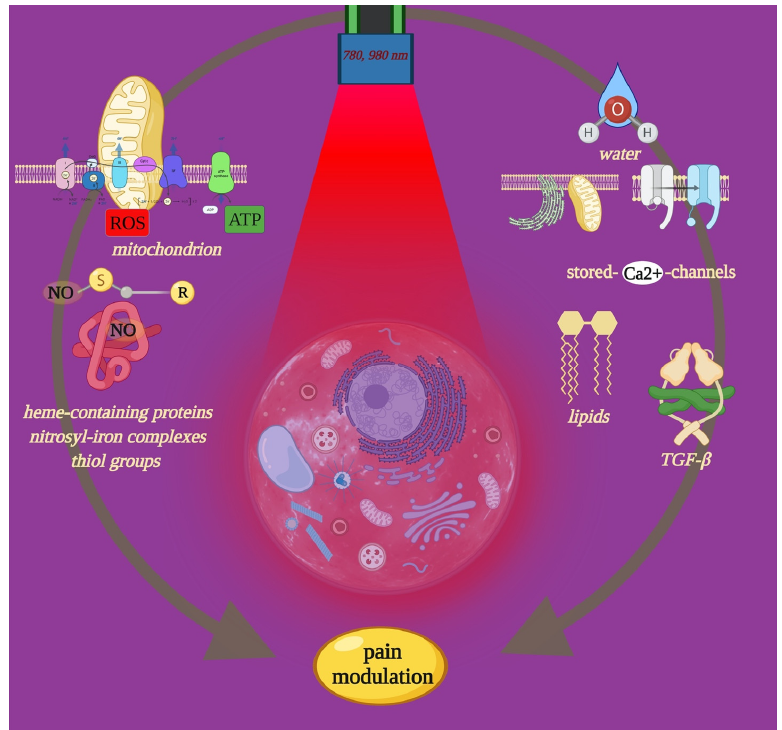
Figure 1. Near-infrared light can interact with molecular photoreceptor cellular involved in metabolism and homeostasis. The figure shows such light targets, which also play key roles in nociceptive signals. Through precise PBM-t, it is possible to modulate pain and support its management. Image created with BioRender.com.